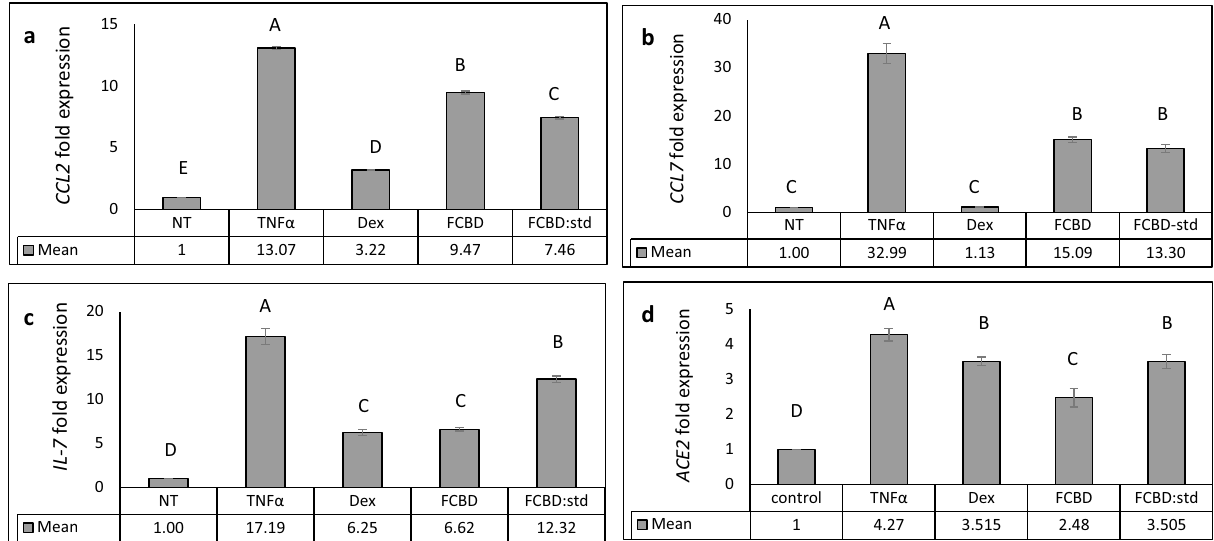
Figure 4. qPCR-based determination of the mRNA steady state level in A549 cell line of ( a ) CCL2 , ( b ) CCL7 , ( c ) IL-7 or ( d ) ACE2 genes, after treatment with TNFα (300 µg/mL), F CBD (FCBD; 7 µg/mL) or F CBD:std (FCBD:std; 7 µg/mL), or Dexamethasone (Dex; 4 µg/mL)—for 6 h relative to the control. Control (0.7% v/v methanol) treatment served as the solvent (vehicle) control; TNFα indicates TNFα+ solvent control treatment. Error bars indicate ± sem (n = 3). Bars labeled with different letters are significantly different from all combinations of pairs according to the Tukey–Kramer HSD test (HSD; P ≤